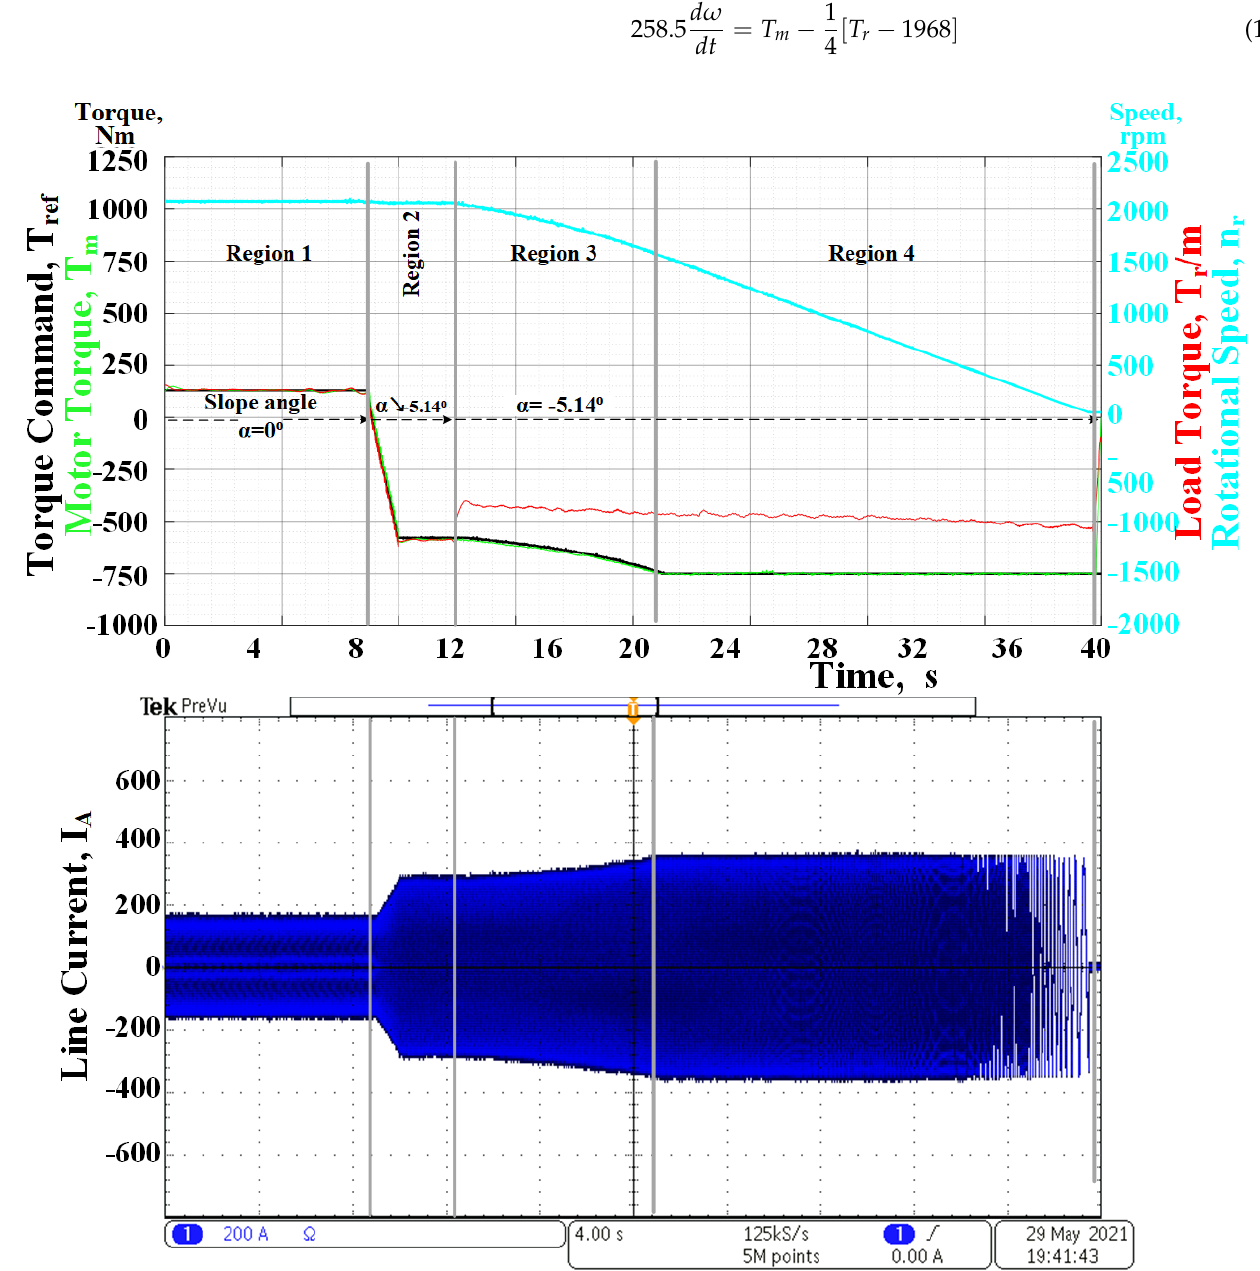
Figure 23. Constant speed operation and then deceleration by regenerative braking while going downhill. Region 1: Constant speed operation, Region 2: Start of regenerative braking operation, Region 3: Deceleration at constant power, Region 4: Deceleration under maximum braking torque, Region 5: Bringing the vehicle to a stop by mechanical brake.